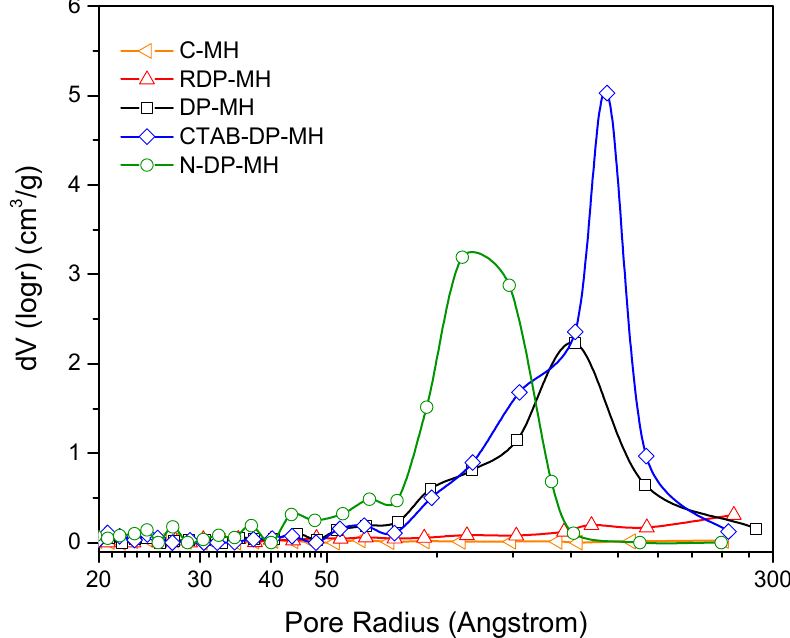
Figure 6. Volume of the pores in relation to their average size for each investigated sample.